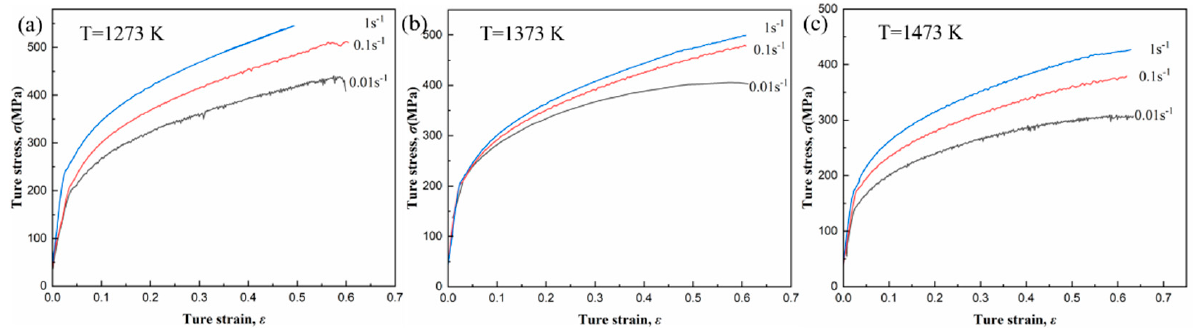
Figure 2. True stress − strain curves of fine-grained pure tungsten obtained from hot compression tests at different strain rates with various temperatures: ( a ) 1273 K, ( b ) 1373 K, ( c ) 1473 K.